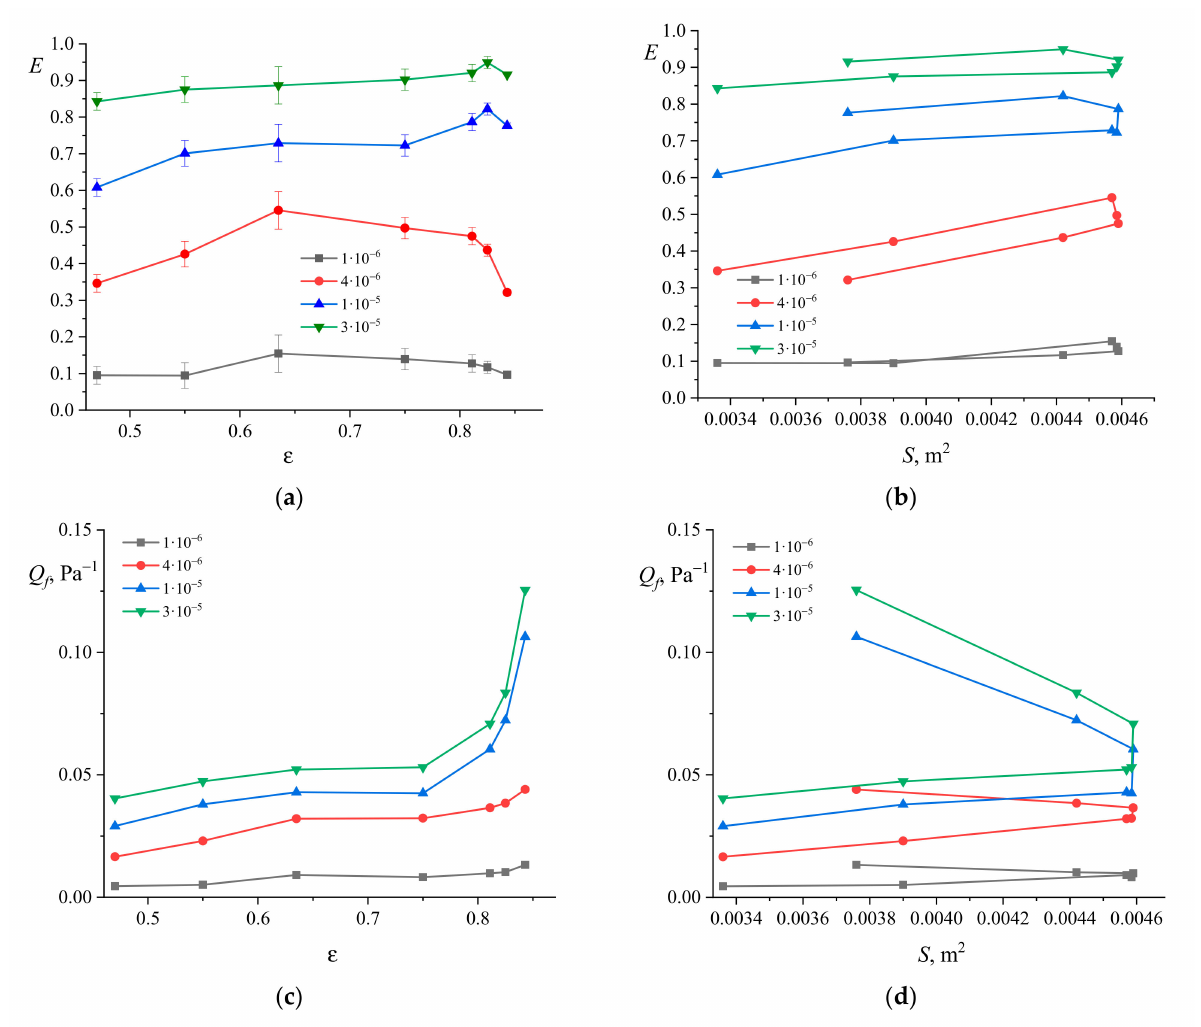
Figure 11. Dependence of the filter characteristics for particle size values d p = 1 µ m, d p = 4 µ m, d p = 10 µ m and d p = 30 µ m: ( a ) particle deposition efficiency on porosity; ( b ) particle deposition efficiency on surface area; ( c ) filter quality on porosity; ( d ) filter quality on surface